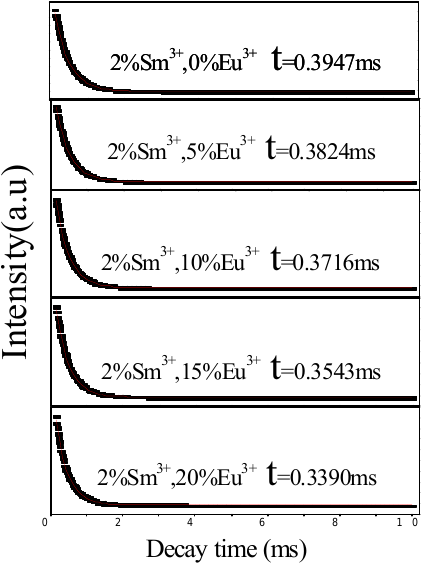
Figure 9. PL decay curves of NL 98% ‐ x MO:xEu 3+ ,2%Sm 3+ . Table 1. Energy transfer efficiency, distance, lifetime of NL 98% ‐ x MO:xEu 3+ ,2%Sm 3+ . Xc/mol %